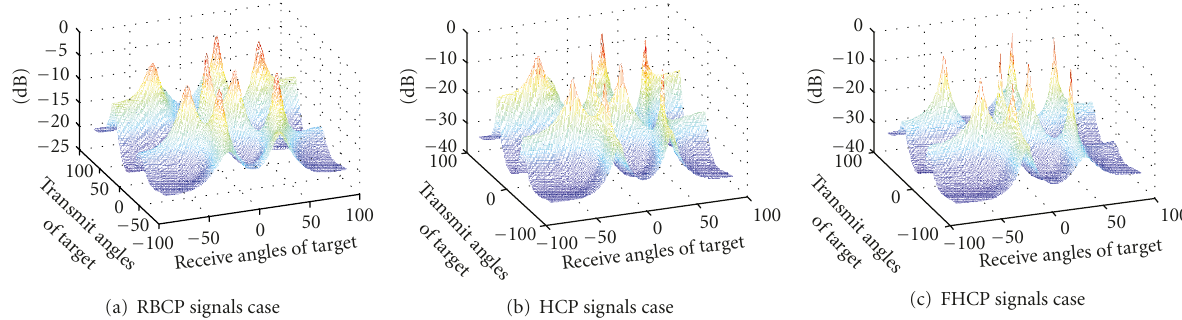
Figure 8: Identification and localization for six targets, SNR = 8dB.